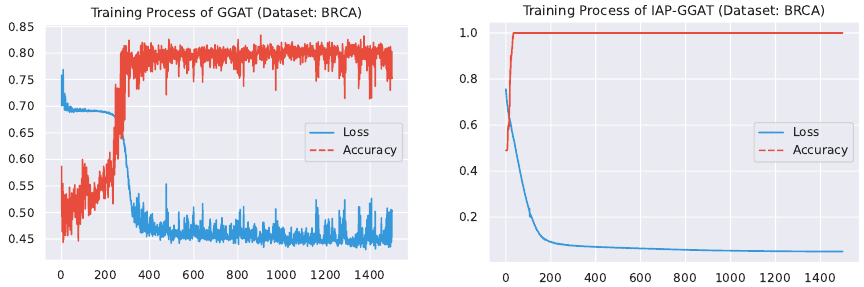
Figure 7. Training process of GGAT and IAP-GGAT on BRCA dataset.